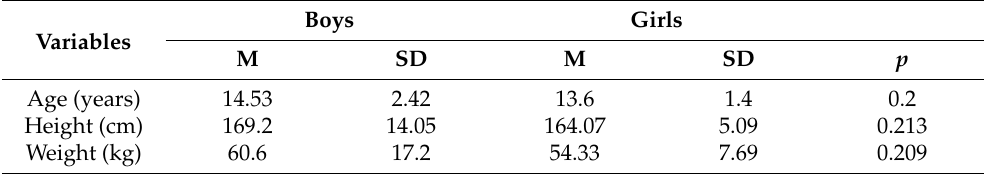
Table 1. Descriptive variables of the sample.